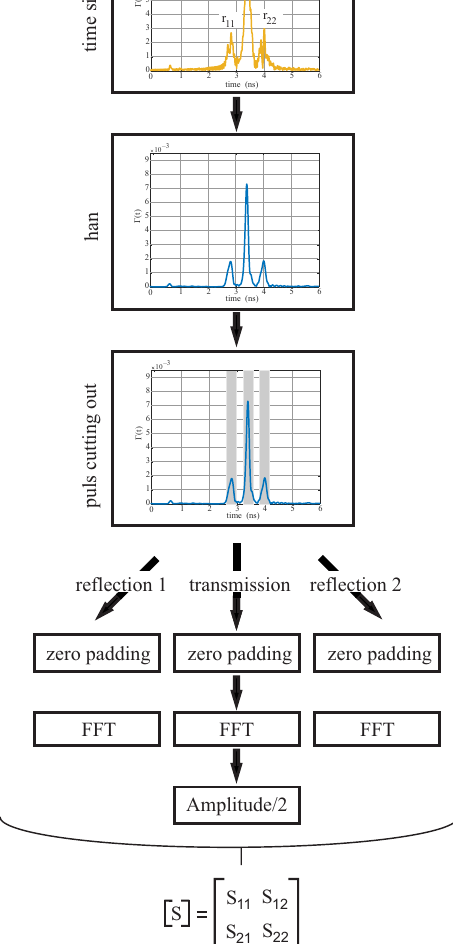
Figure 8. Extraction of the